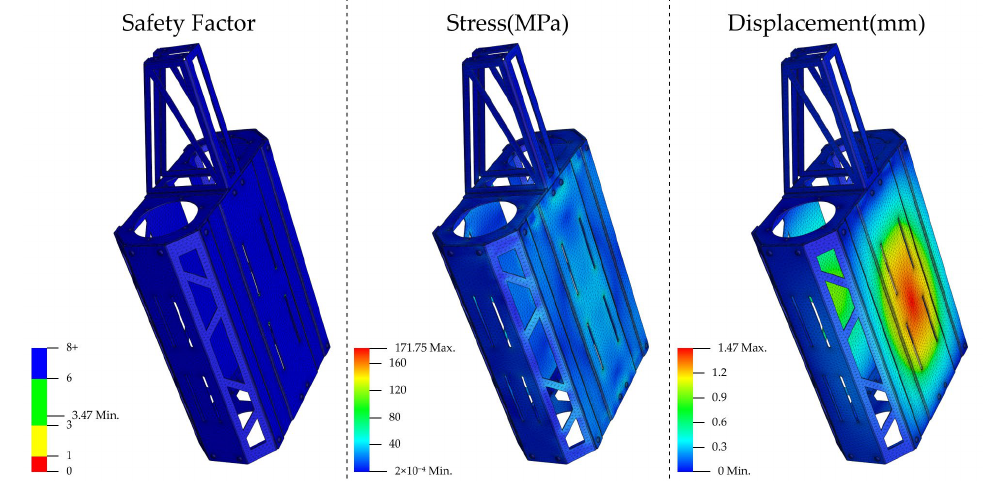
Figure 20. Torso shell analysis. From left to right are safety factor, stress, and displacement.